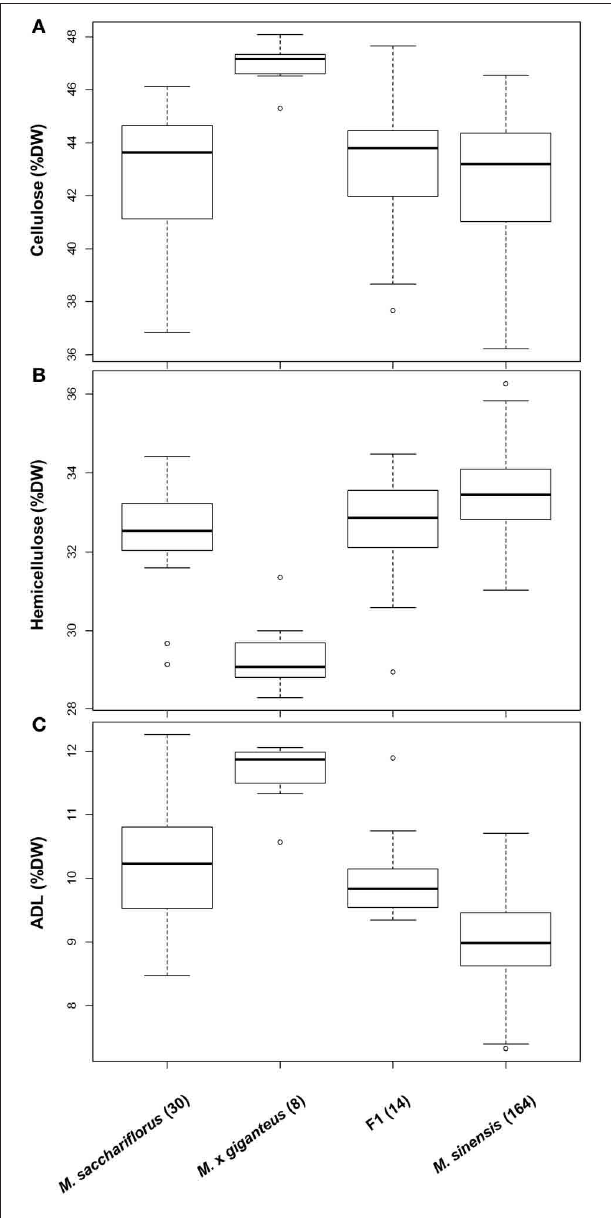
FIGURE 4 | Genetic variation for cellulose (A), hemicellulose (B) and lignin (C) contents in two Miscanthus species and their hybrids. Data from a previous study (Allison et al., 2011) were re-analysed after classifying genotypes using 120 single nucleotide polymorphisms (Slavov et al., 2013). Distributions are based on least square means corrected for year and block effects (Allison et al., 2011). Boxes delineate inter-quartile ranges (IQR), whiskers extend to 1.5 × IQR, and thick lines correspond to medians. The number of genotypes in each group is shown in parentheses. ADL, acid detergent lignin; DW, dry weight; F1, hybrids with estimated M. sinensis : M. sacchariflorus admixture proportions between 1:2 and 2:1.